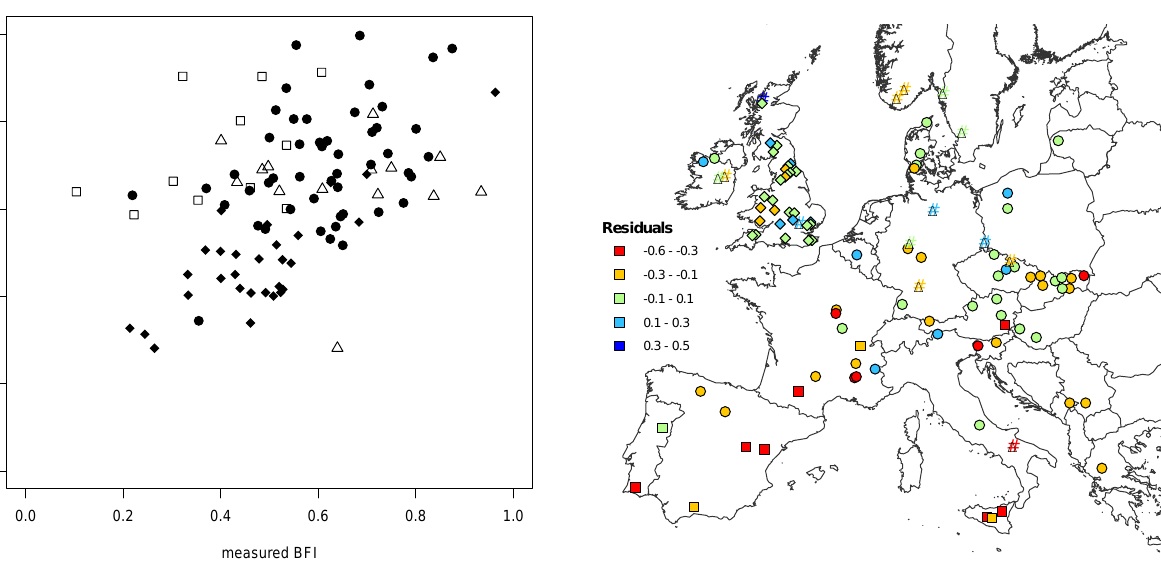
Fig. 3. Prediction of the BFI in 103 European catchments clus- tered into four groups: Triangles: Catchments governed by major artificial influences, large lake fractions, subsurface water sources or extreme climatic conditions (Group A); Squares: Catchments whose coefficient of variation of the annual BFI was larger than 0.18 (Group B); Rhomboids: Catchments in England and Wales (Group C); Circles: Remaining catchments outside England and Wales (Group D).